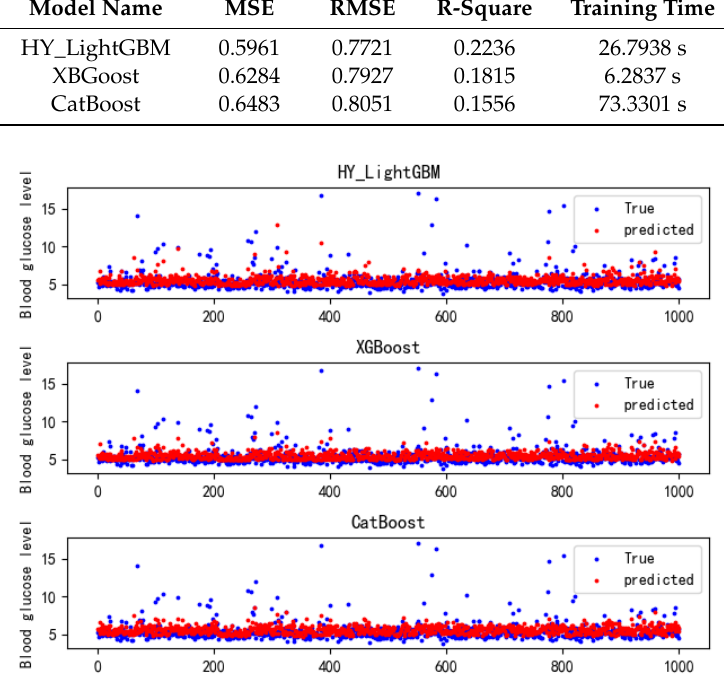
Figure 12. Performance comparison chart of HY_LightGBM, XGBoost, and CatBoost.